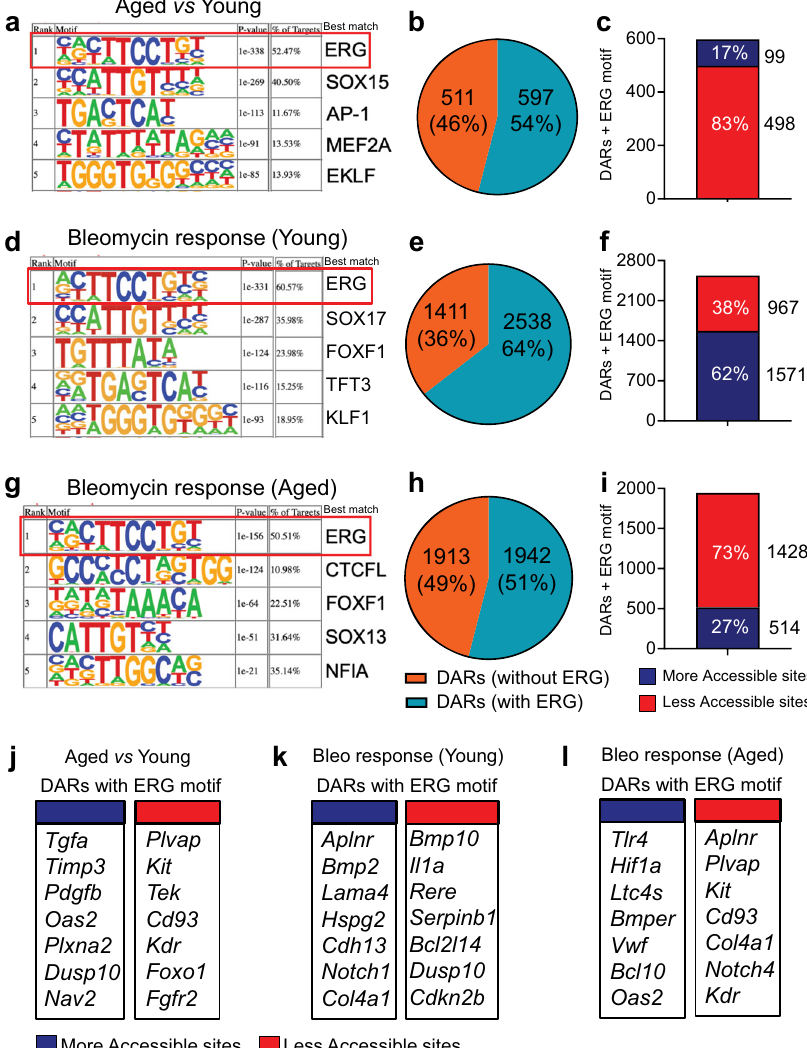
Fig. 2 Motif analysis identi fi es ERG as a putative driver of lung vascular repair. a , b De novo DNA motif analysis identi fi es ERG enrichment in more than 50% of differentially accessible chromatin sites in aged lung ECs relative to young ones. c In aged lung ECs ERG motif was associated with chromatin regions that exhibited reduced accessibility. d , e ERG enrichment was also observed in differentially accessible chromatin regions in young lung ECs following bleomycin challenge. f In young lung ECs ERG motif was associated with chromatin regions that exhibited increased accessibility. g , h Similarly to young lung ECs, ERG motif was also enriched in aged lung ECs following bleomycin challenge. i As opposed to young lung ECs, injured aged lung ECs exhibited ERG enrichment in chromatin areas with reduced accessibility. Motifs displayed in a , d , g were ranked by p value. j Representative ERG-target genes associated with differentially accessible chromatin regions in aged vs young lung ECs, and in injured young ( k ) and in injured aged lung ECs ( l ) relative to uninjured young lung ECs. ATAC-seq peaks associated with genes displayed in j , k , l were identi fi ed by a p value ≤